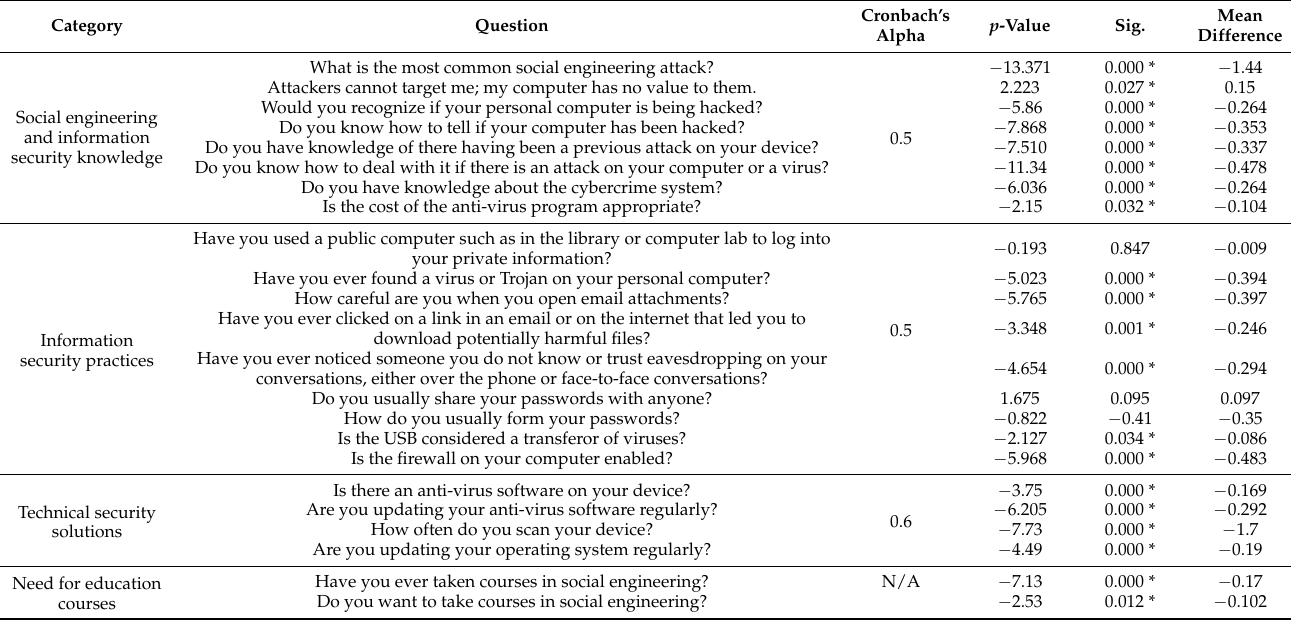
Table 4. t -test results of the significance of prior knowledge of social engineering approaches to the level of awareness. Category